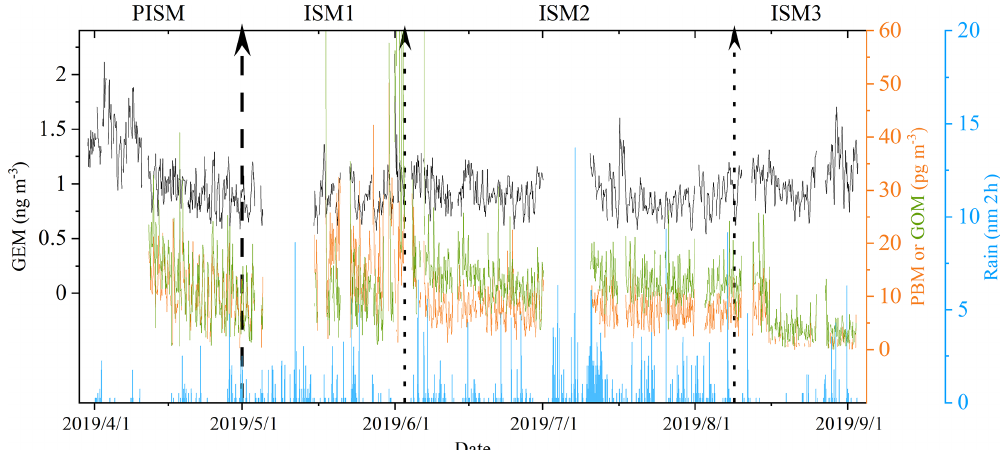
Figure 2. Time series of GEM, GOM, and PBM concentrations and the rainfall over the sampling period. The GEM concentration resolution is 5min, and the GOM, PBM, and rain resolutions are 2h. According to the characters of monsoon development and precipitation, the monitoring periods are divided into four segments, namely PISM (before May), ISM1 (1 May–2 June), ISM2 (3 June–8 August), and ISM3 (after 9 August).